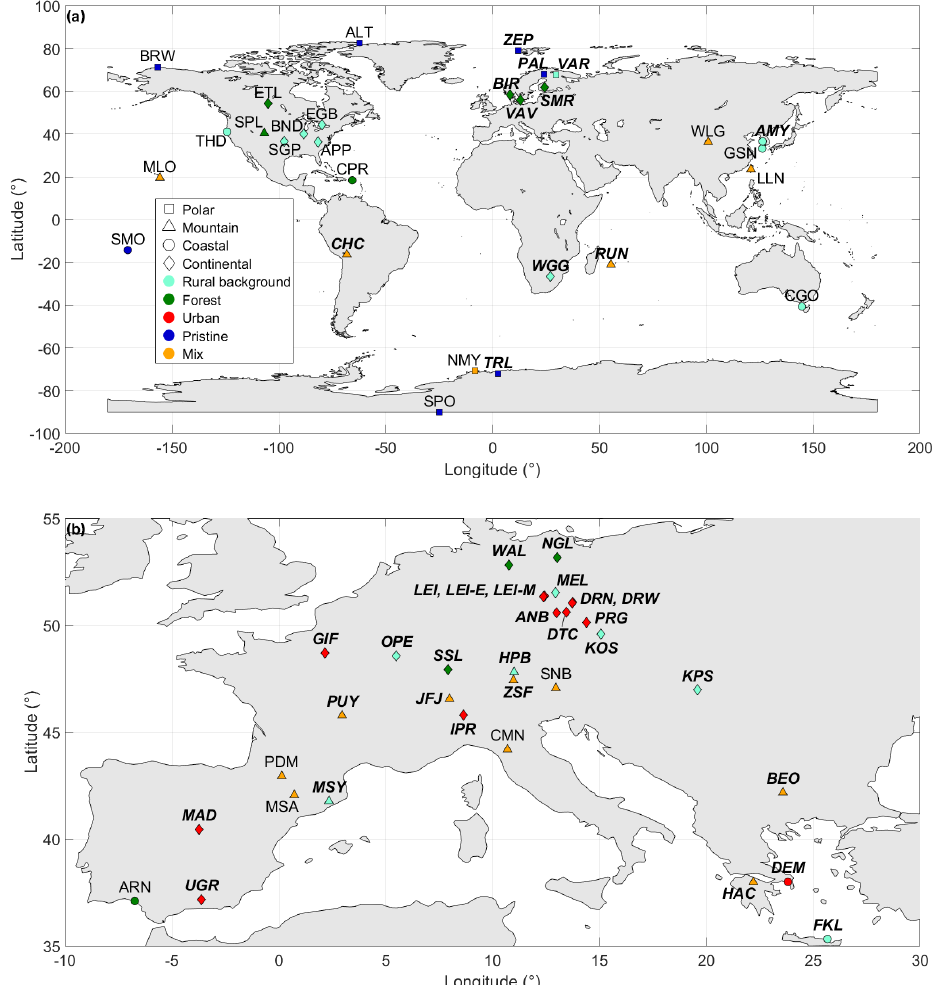
Figure 1. Geographical distribution of the stations with their abbreviations (see Table 1) (a) at the global scale and (b) specifically over central and southern Europe. The shapes and colours of the markers indicate geographical and footprint categories, respectively. The sites operating a mobility particle size spectrometer (MPSS) are additionally marked in italic